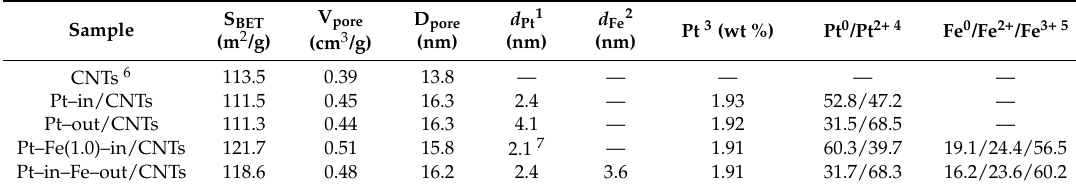
Table 1. Physicochemical properties of carbon nanotubes (CNTs) and